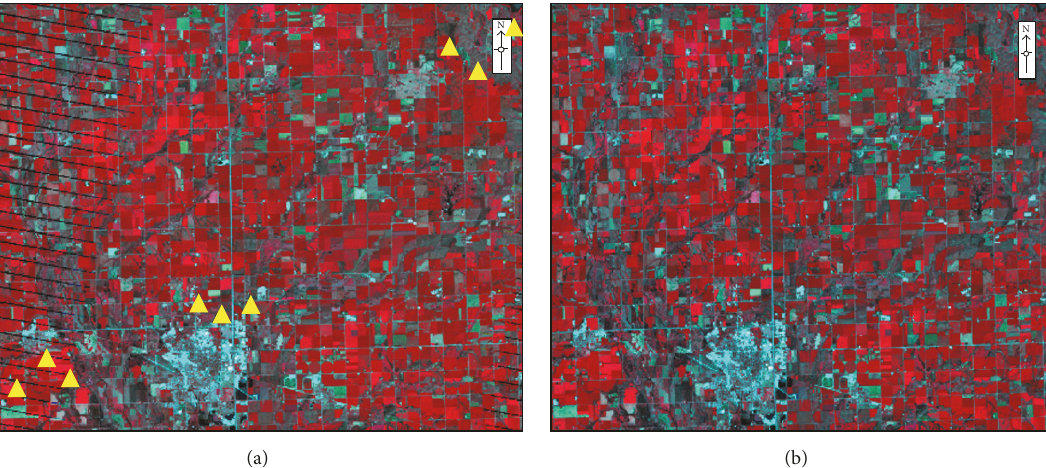
Figure 2: Stripes removed from Landsat 7 image. Original image with nine yellow triangles that indicate corn field sites (a) and final image without stripes, where SLC-off image is filled after employing the focal analysis tool two times